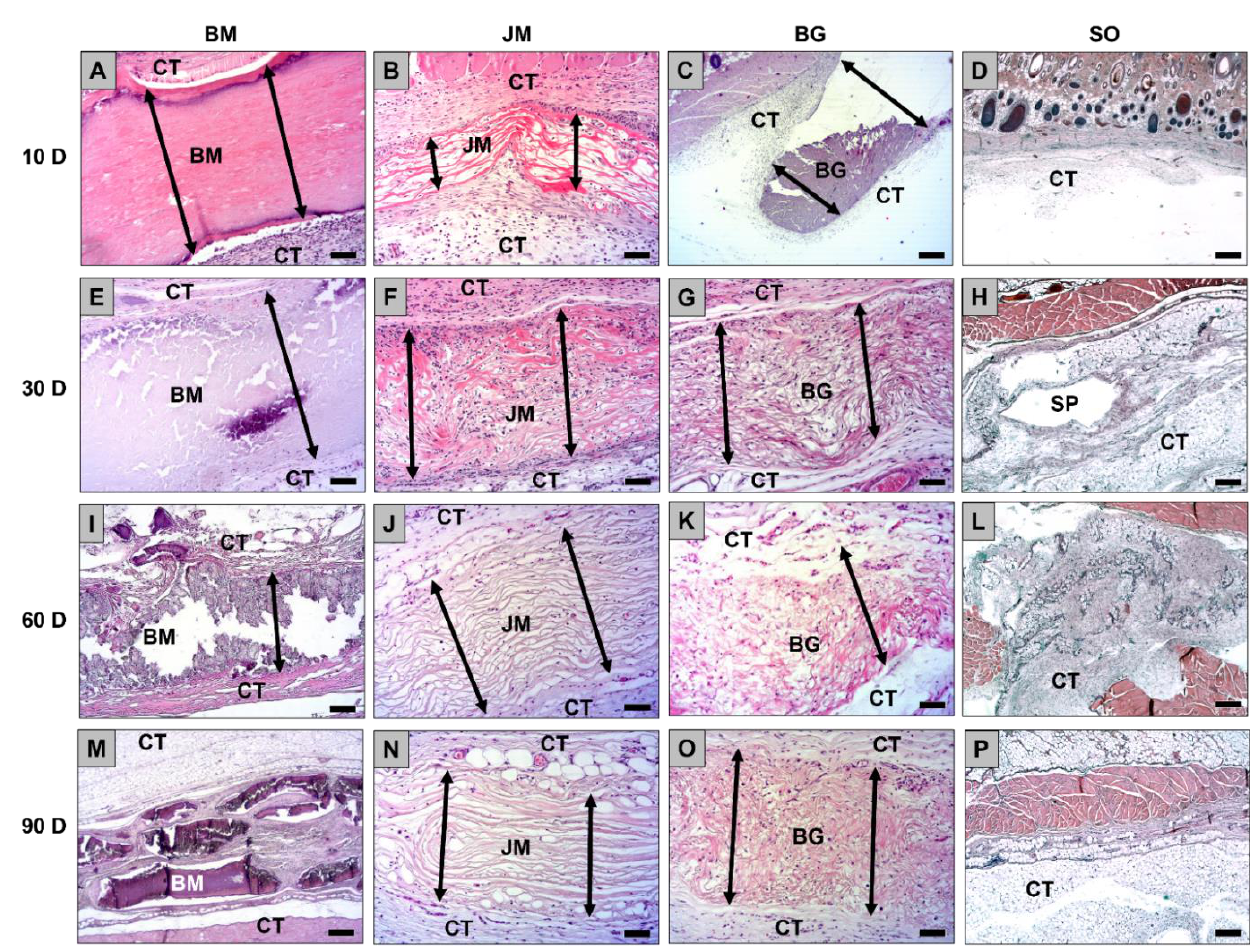
Figure 2. Exemplary histological images of the three membranes ( A – C , E – G , I – K , M – O , double ar- rows) and the sham operation ( D , H , L , P ) within the subcutaneous connective tissue (CT) at day 10, 30, 60, and 90 post implantationem. SP = subcutaneous pocket of the sham operation. BM = bovine membrane, JM = Jason ® membrane, BG = Bio-Gide ® membrane, SO = sham operation (H&E-stainings, 40× magnifications, scalebars = 100 µm).